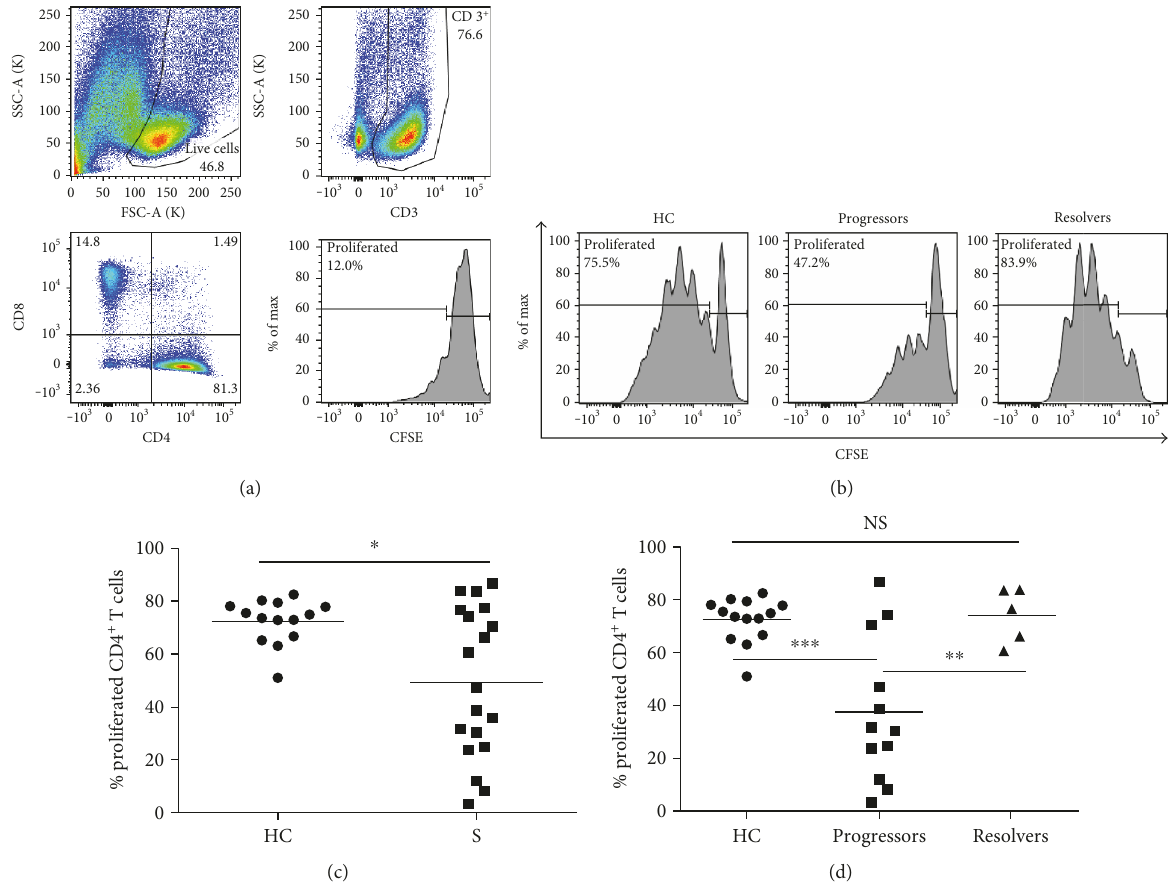
Figure 2: Proliferative capacity in sarcoidosis CD4 + T cells. PBMC were labeled with 2.5 μ M CSFE, TCR stimulated, and cultured for 5 days in supplemented RPMI 1640 medium. Cells that had not received polyclonal TCR activation were cultured alongside the stimulated cells as a negative control. On day 5, cells were collected and stained with anti-CD3, anti-CD4, and anti-CD8. After fi xation, cells were analyzed by fl ow cytometry to assess cell size and the intensity of the CFSE signal. (a) Representative fl ow cytometry data illustrating the gating strategy used to quantitate the percentage of proliferating cells. Brie fl y, live, singlet CD3 + cells were gated according to CD4 and CD8 expression. The population of CD4 + cells was then gated based on the intensity of CFSE signal. The peak at the far right on the CFSE histogram represents cells that had not proliferated by day fi ve; peaks to the left of this nonproliferating population indicate cells that had proliferated. (b) Representative histograms of sarcoidosis progressor and resolver proliferating CD4 + T cells. (c) Plot of healthy control (HC) and sarcoidosis proliferating CD4 + T cells. Statistical analysis was performed using the Mann – Whitney U test. (d) Plot of healthy control and sarcoidosis progressor and resolver proliferating CD4 + T cells. Statistical analysis was performed using one-way ANOVA with Tukey ’ s HSD. Horizontal lines represent mean percentages of proliferating CD4 + T cells. ∗ p < 0 05 , ∗∗ p < 0 01 , and ∗∗∗ p < 0 001 . NS: not signi fi